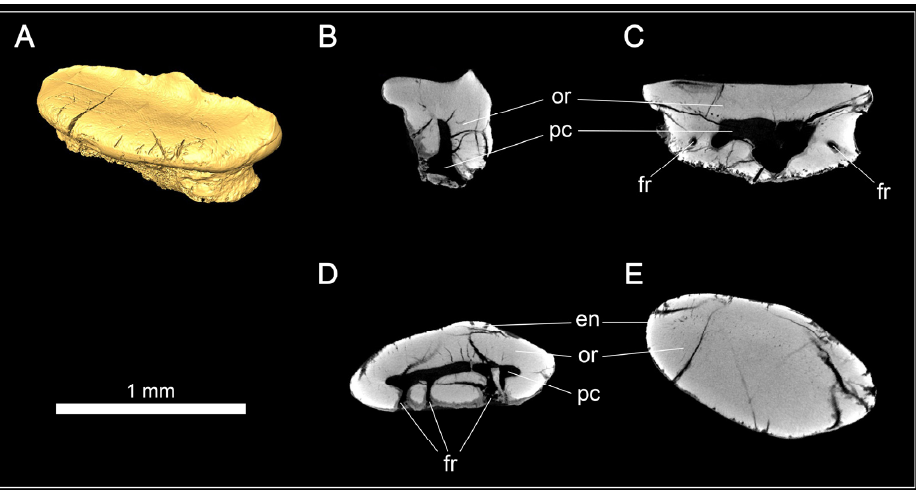
Figure 5. Micro-CT images and tooth histology of Protospinax annectans Woodward, 1918, EMRG- Chond-T-80, from the lower Tithonian of the Solnhofen Archipelago, Bavaria, Germany. ( A ) Isosurface; ( B ) virtual section of the tooth through the sagittal plane; ( C ) virtual section of the tooth through the frontal plane; ( D ) virtual section of the root through the axial plane; ( E ) virtual section of the crown through the axial plane. Abbreviations : en , enameloid; fr , foramen; or , orthodentine; pc , pulp cavity.